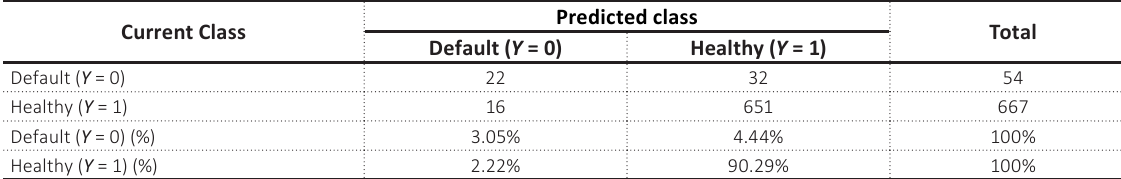
Table B8. The matrix of classification gap